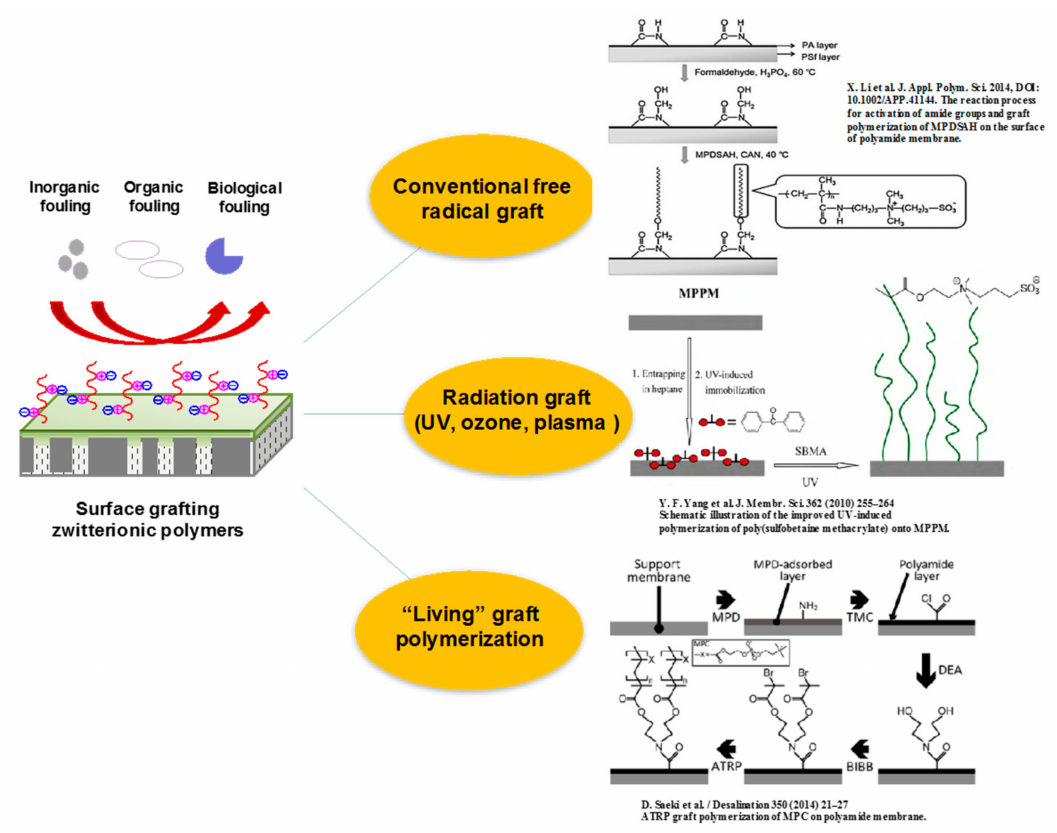
Figure 16. Representative, not comprehensive, summary of surface grafting zwitterionic polymers research: the reaction process for the activation of amide groups and graft polymerization of MPDSAH on the surface of polyamide membrane; schematic illustration of the improved UV-induced polymerization of poly(sulfobetaine methacrylate) onto MPPM; ATRP graft polymerization of MPC on a polyamide membrane. Reproduced with permission from References